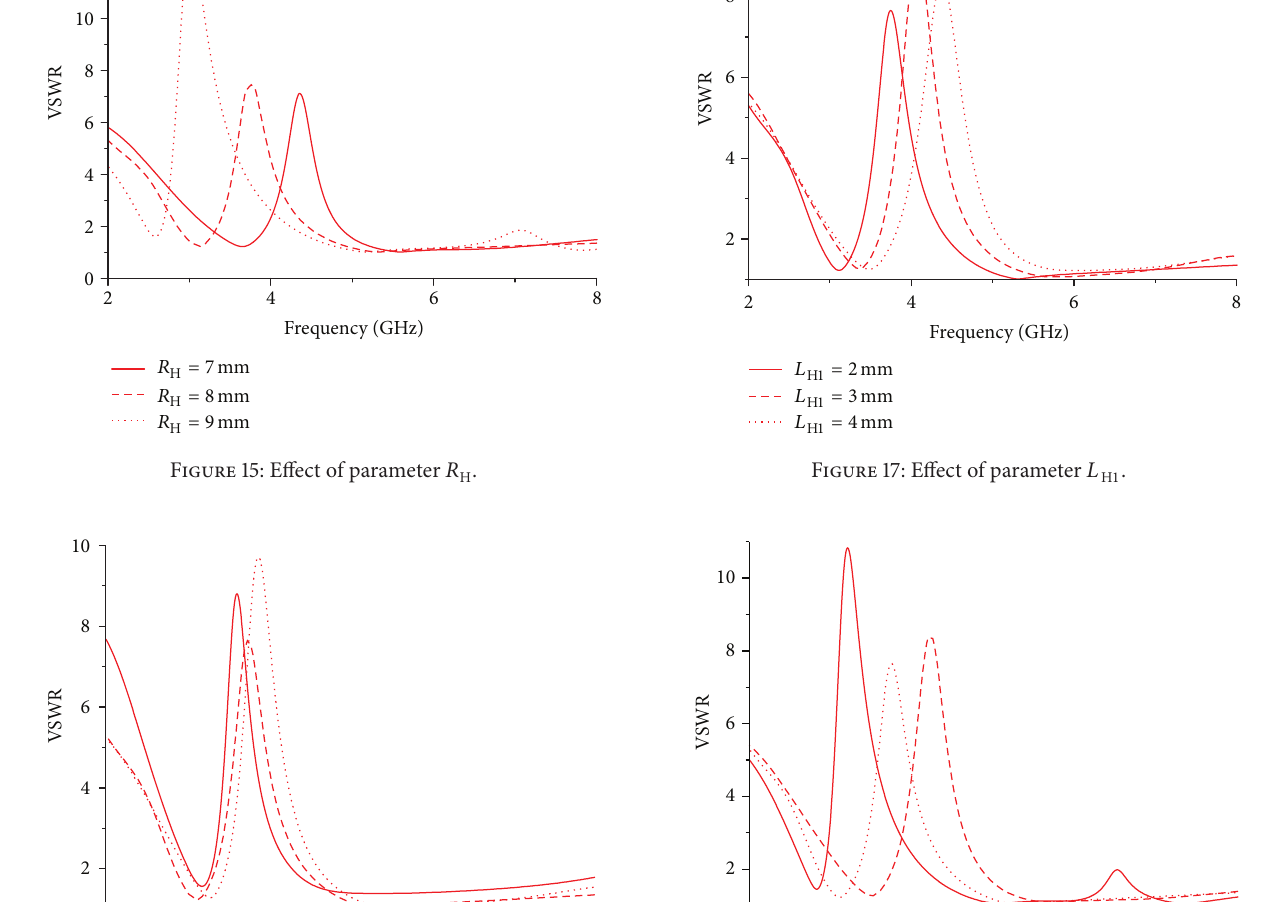
Figure 18: Effect of parameter angle 𝛼